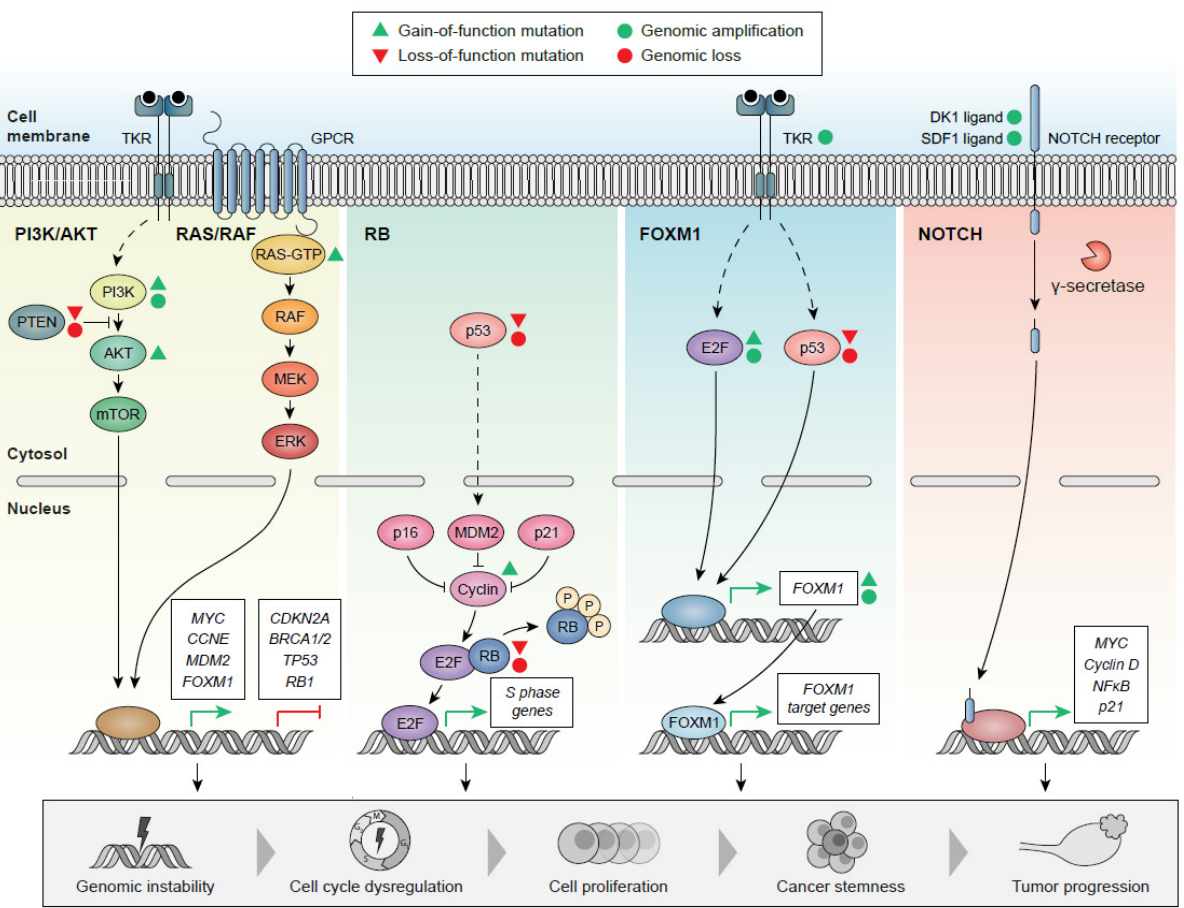
Figure 2. Frequently altered signaling pathways in HGSOC: Different mutations and genomic aberrations affect the PI3K/Akt, Ras/Raf, Rb, FOXM1, and Notch pathways, resulting in the dysregulation of downstream target gene expression, which can subsequently promote genomic instability, cell-cycle dysregulation, enhanced cell proliferation, cancer stemness, and tumor progression.